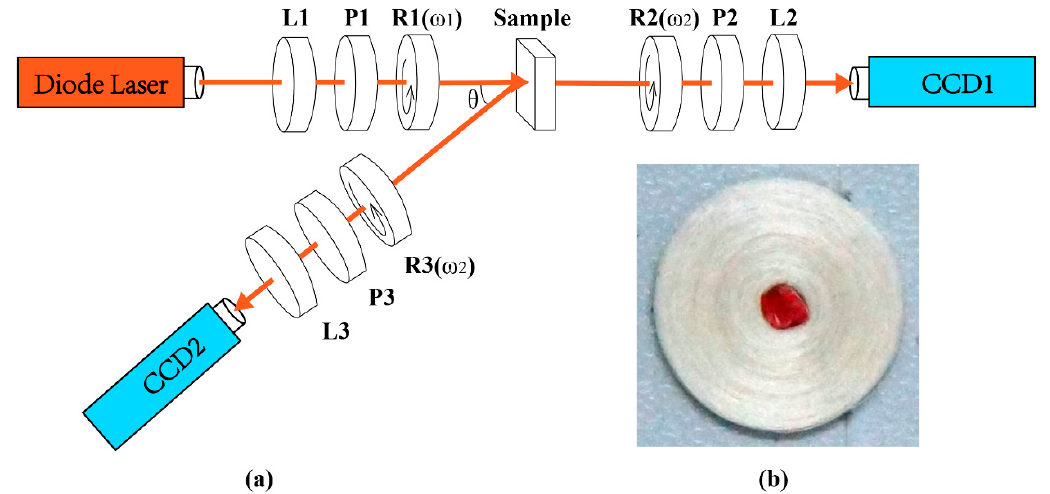
Figure 1. ( a ) Schematic of the Mueller matrix configuration for both backscattering and transmission measurements. L1, L2, L3: lens; P1, P2, P3: polarizer; R1, R2, R3: quarter-wave plate. ( b ) Silk phantom; the diameter of the silk fiber is 1.5 µ m and its refractive index is 1.56; the scattering coefficient of the silk layer is 70 cm − 1 , the outer diameter of the phantom is 1.5 cm and its thickness is 2 mm.